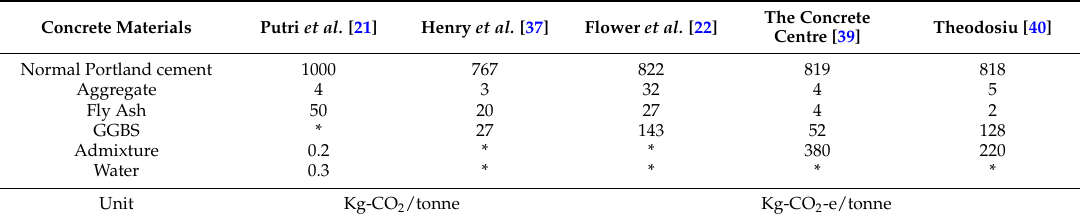
Table 5. Overall CO 2 emission comparison.